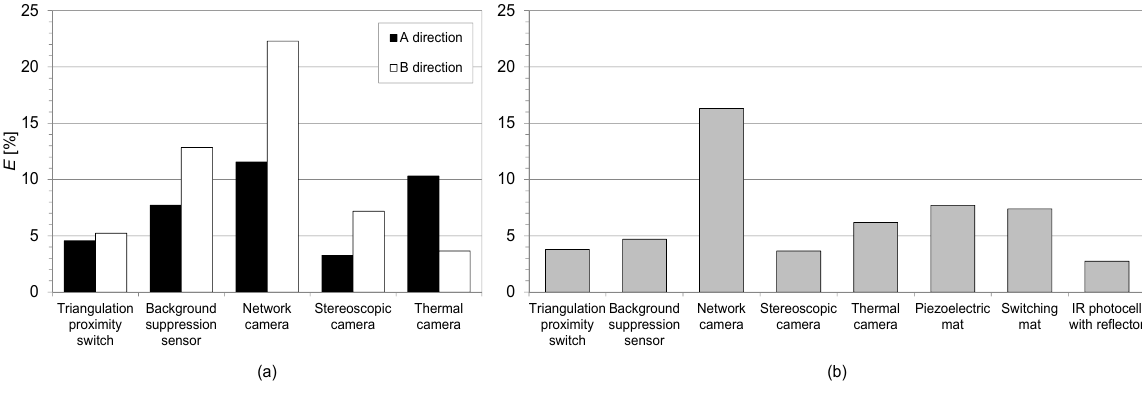
Figure 3. The observed overall error rates ( E ) of the sensor readings, ( a ) for separate directions and ( b ) omitting the